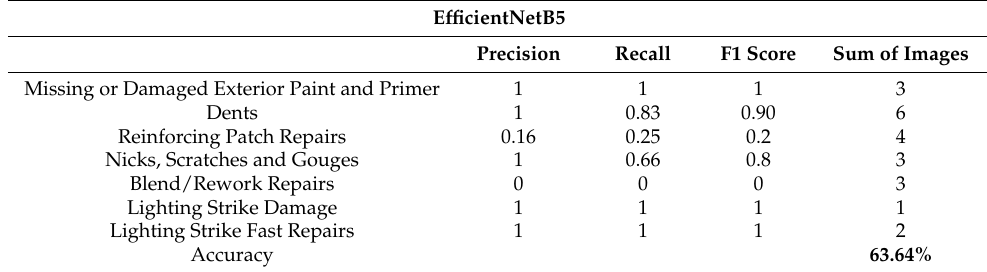
Table 15. Classification report of EfficientNetB5 for defect classification.